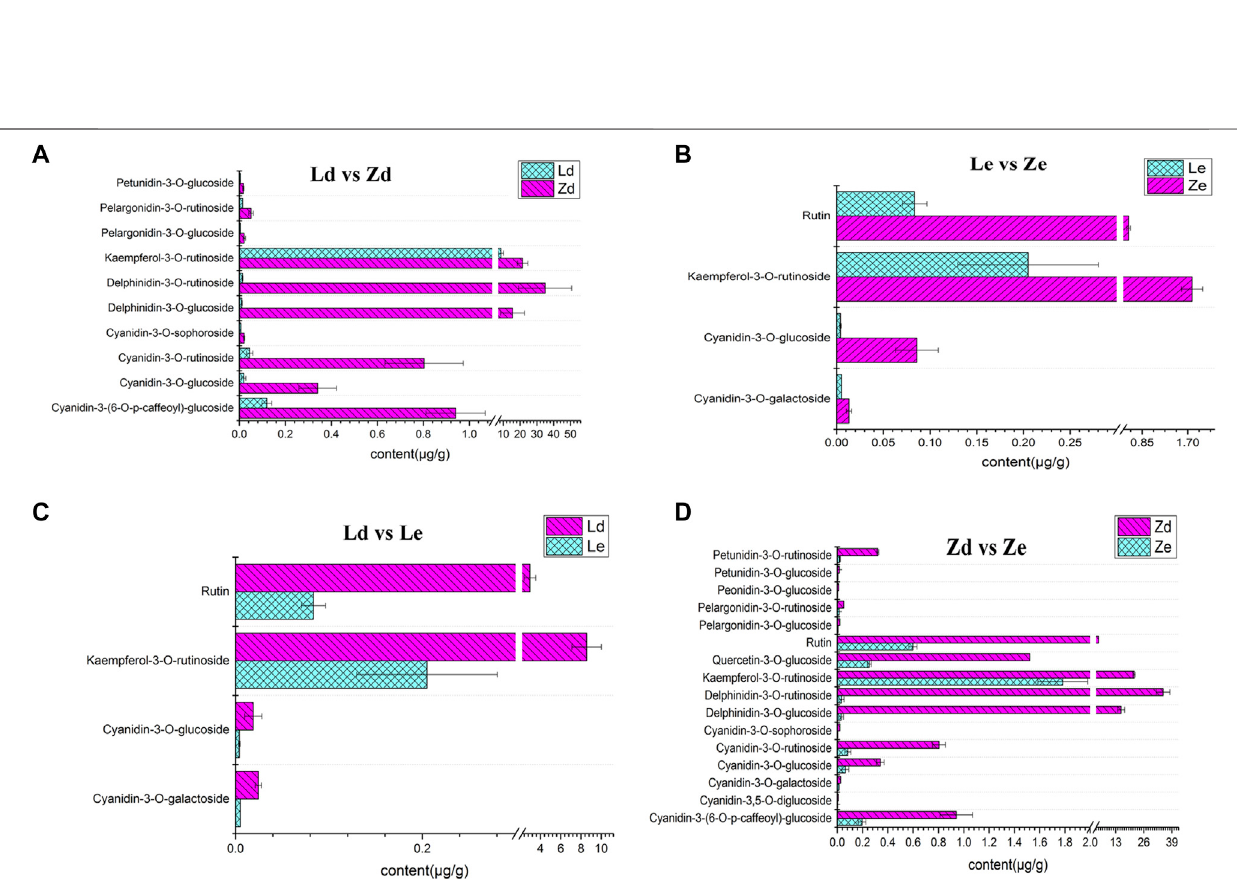
Frontiers in Genetics |